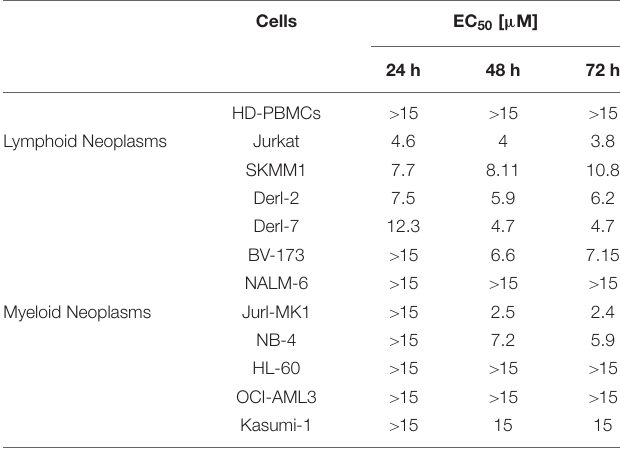
TABLE 2 | EC 50 values calculated in Healthy donors-peripheral blood mononuclear cells (HD-PBMCs) and in both lymphoid and myeloid cell lines after 4c compound